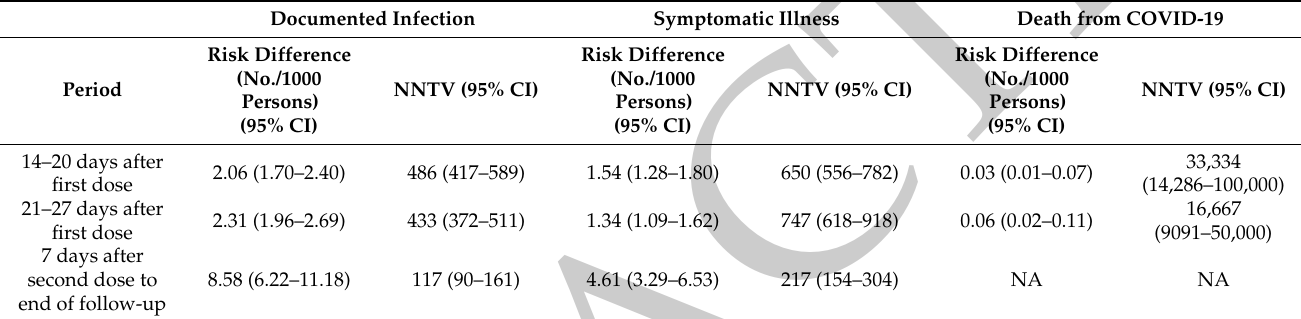
Table 1. Risk differences and number needed to vaccinate (NNTV) to prevent one infection, one case of symptomatic illness, and one death from COVID-19. Data from Dagan et al. [6], N = 596,618 in each group. Documented Infection Symptomatic Illness Death from COVID-19